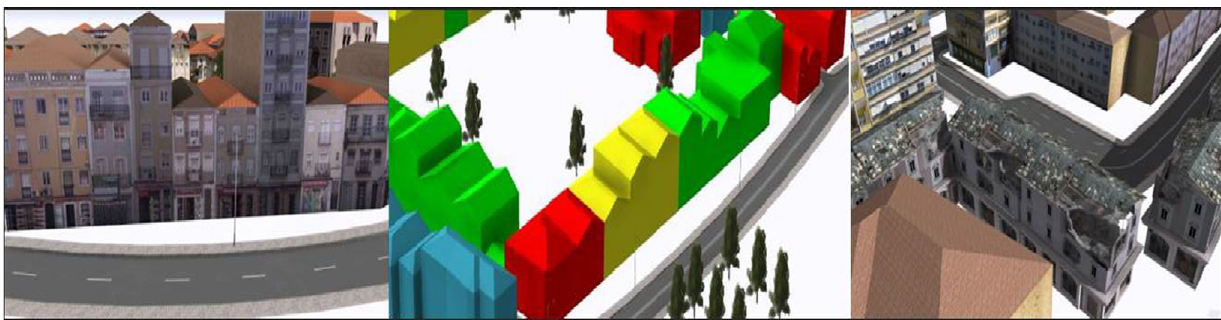
Fig. 2 Appearance of buildings in 3D model according to query context: actual texture (left); colored symbology (middle); damage realistic texture (right)